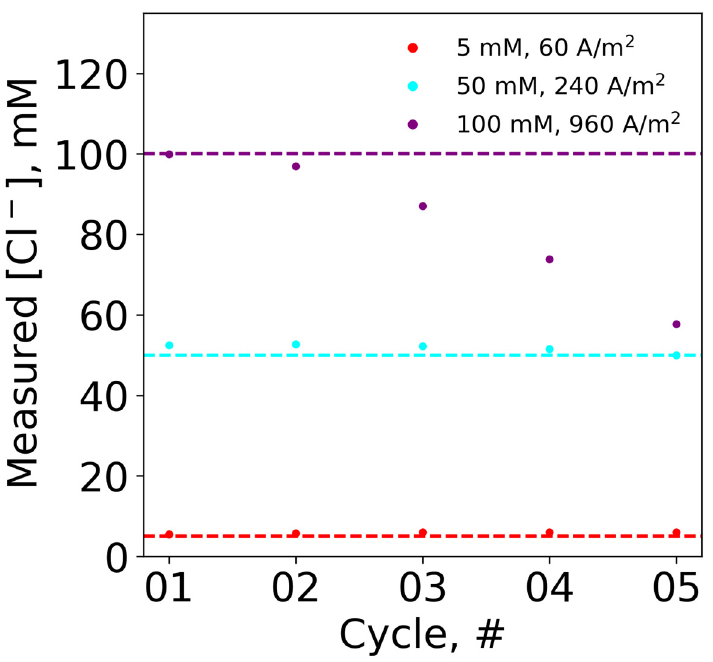
Figure 7. The measured chloride concentration, from back calculation using transition time, versus cycle number, using fresh 5 mL solutions with a reused sensor with 5 mM NaCl at 60 A/m 2 , 50 mM NaCl at 240 A/m 2 , and 100 mM at 960 A/m 2 , in solutions of 20 mM Na 2 SO 4 at room temperature, run for 3 s, or until the 0.9 V cutoff was reached.